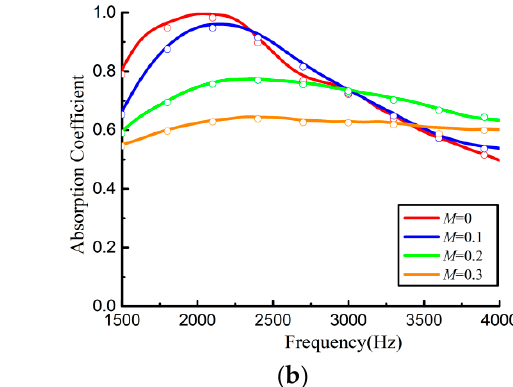
Figure 17. Geometric and detailed FE models of the RDPAA system with grazing flow (suitable for the IBNSE method). ( a ) Geometric model and ( b ) FE model.